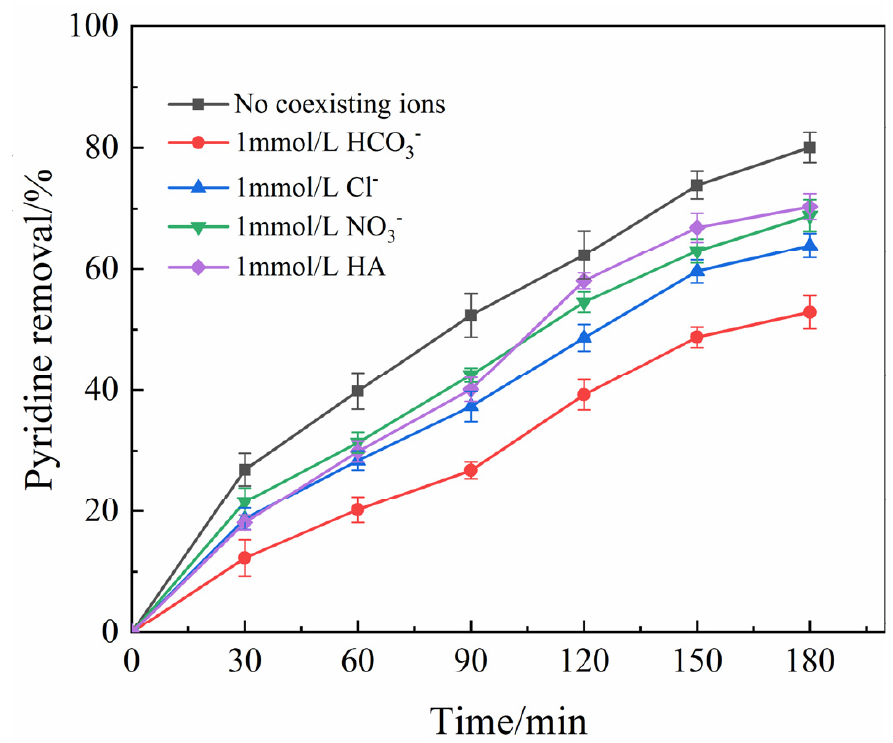
Figure 6. Effect of coexisting ions on the degradation of pyridine (pH = 8, La − Fe − TiO 2 @MSP dosing 800 mg/L, pyridine initial concentration 50 mg/L, photocatalytic time 3 h, light intensity 560 W, temperature 35 °C).